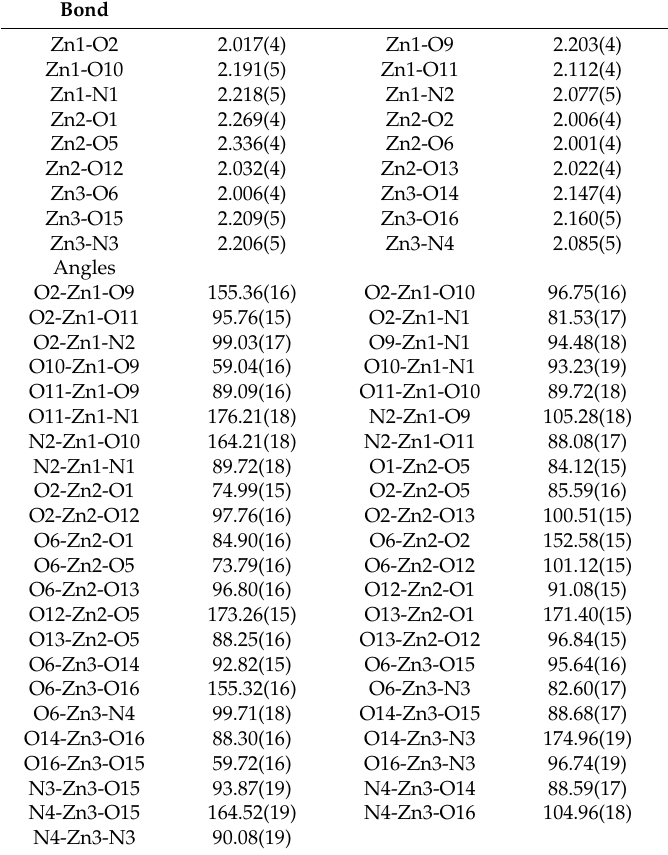
Table 4. Selected bond lengths (Å) and angles ( ◦ ) for complex 2